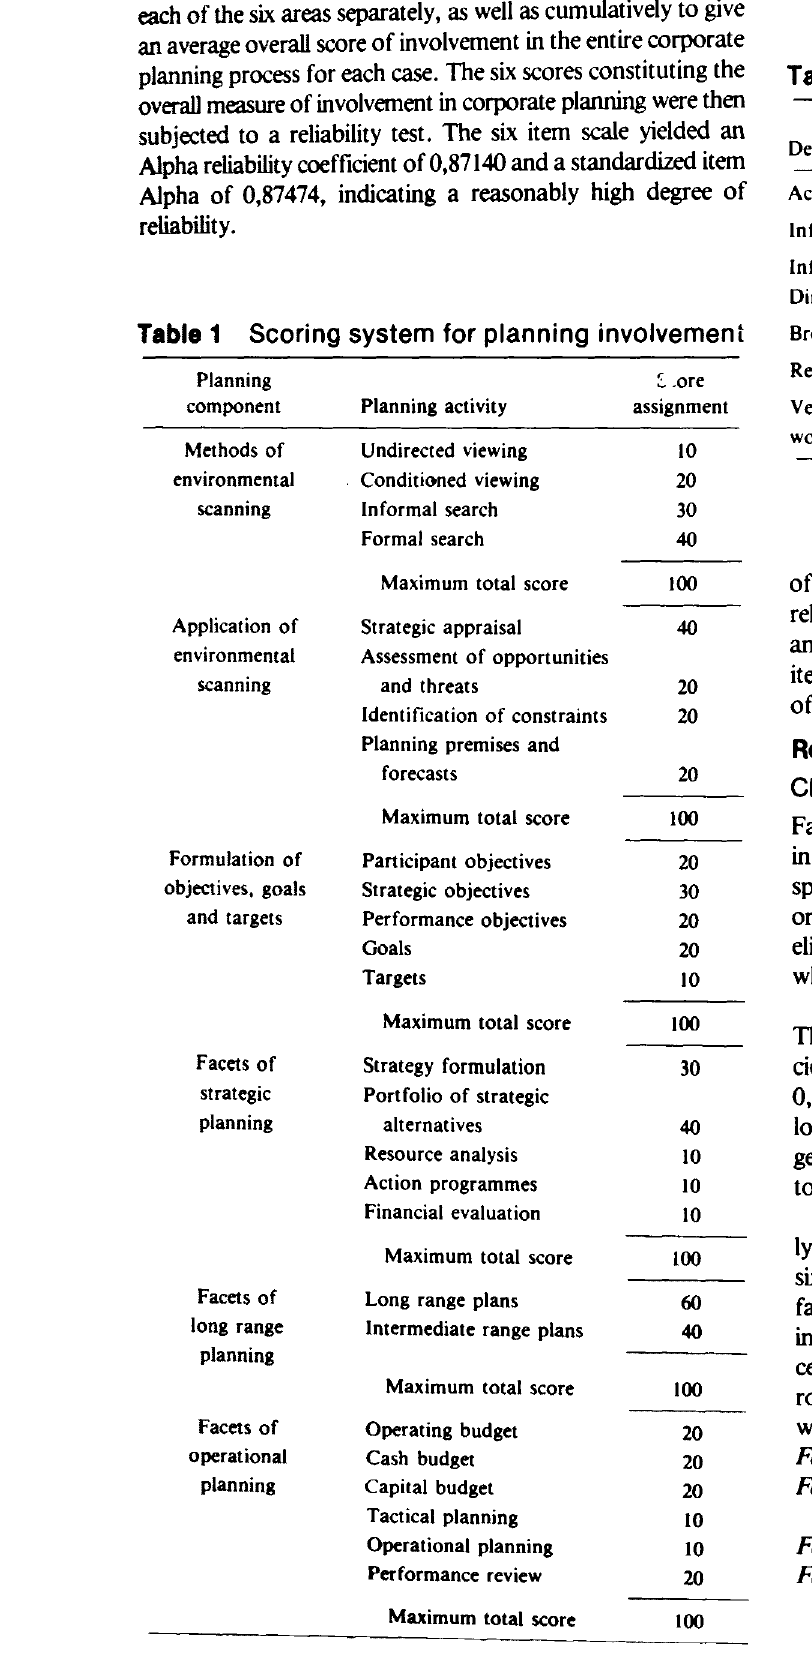
Table 1 Scoring system for planning